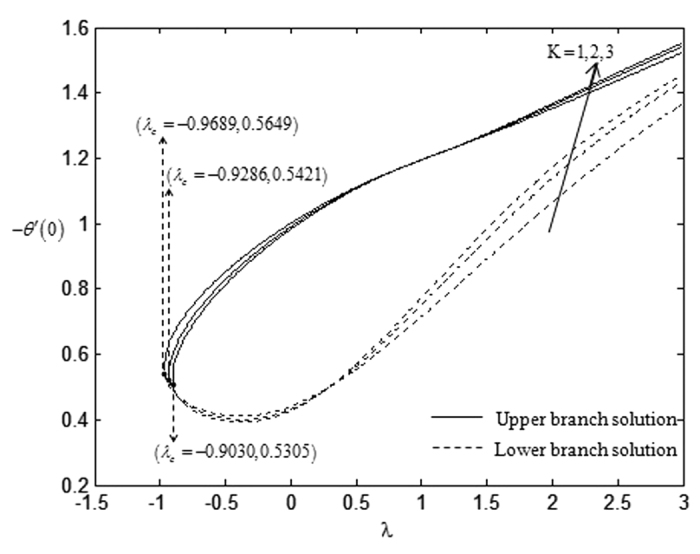
Variations of −θ′(0) with λ for some values of K when β = −1 and s = 1.